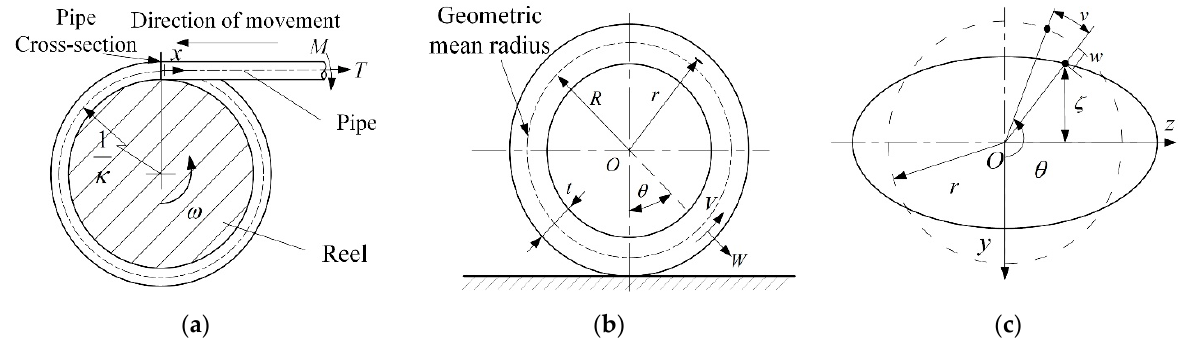
Figure 5. Geometric parameters and coordinate system.